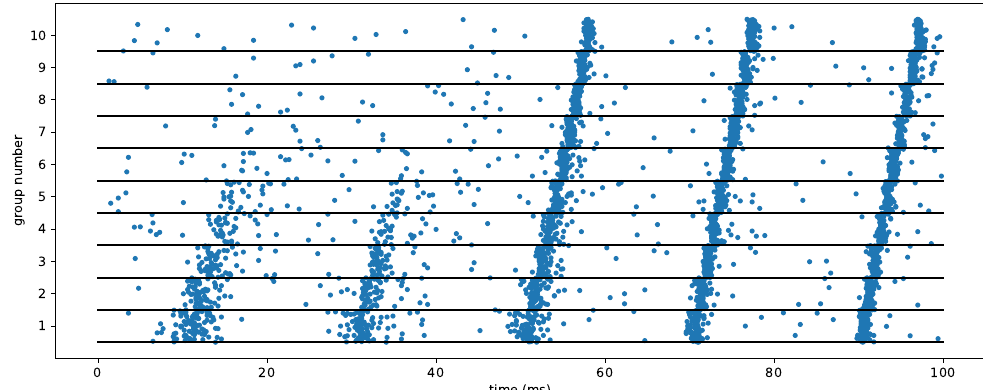
Figure 3. Simulation of a synfire propagation using Brian. The model consists of 10 groups (arranged with the first group represented in the lowest row) of 100 neurons each. Five pulses with decreasing jitter are generated in the first group around times 10, 30, 50, 70 and 90 ms (with jitters given by a standard deviation which linearly decreases from 5 to 1 ms). This generates a pulse after a certain processing delay in the second group with a different jitter. While the first two pulses progressively vanish in the following groups, starting from the third input pulse (with a jitter of 3 ms), it is propagated to the following groups. This allows the propagation of the synchronous activity along the chain of the neural